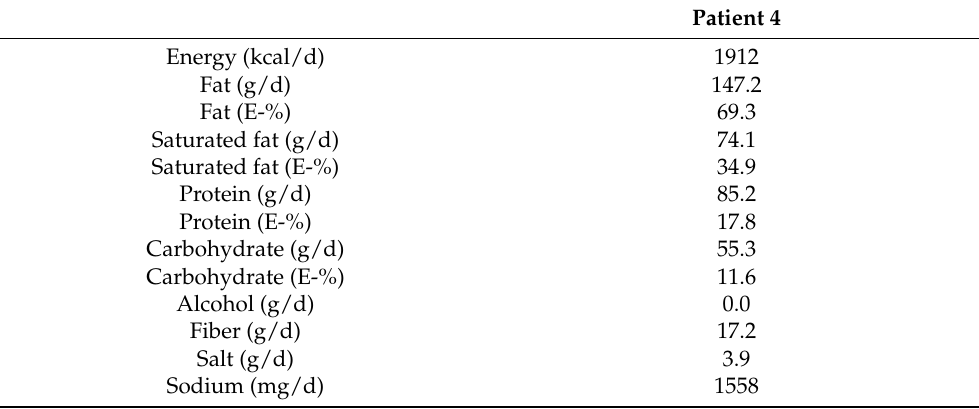
Table A2. Calculated energy (kcal) and macronutrient (g and E-%), fiber (g), salt (g), and sodium (mg) intake on an example day of case 4 on a low-carbohydrate, high-fat